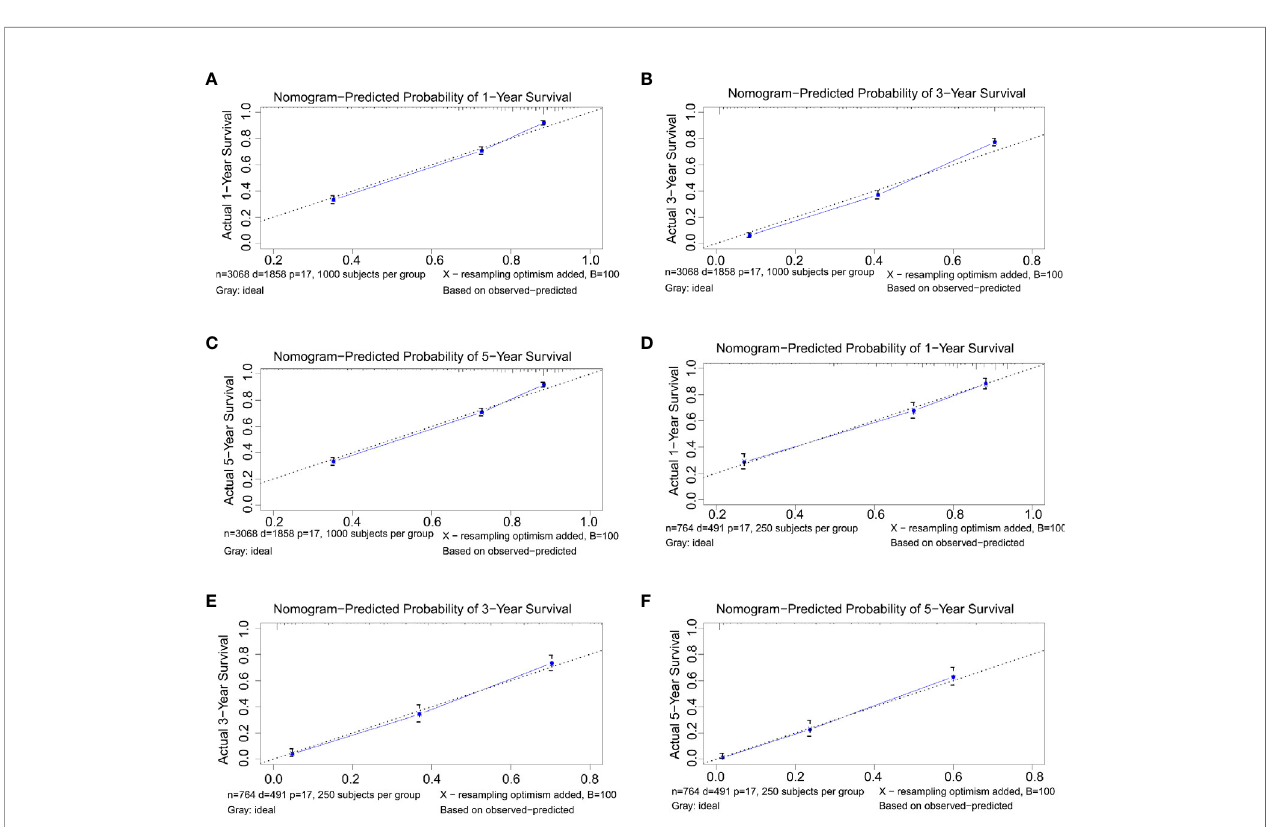
FIGURE 3 | (A – C) Nomogram calibration plots to predict 1-, 3-, and 5-year overall survival (OS) in the training cohort. (D – F) Nomogram calibration plots to predict 1-, 3-, and 5-year OS in the validation